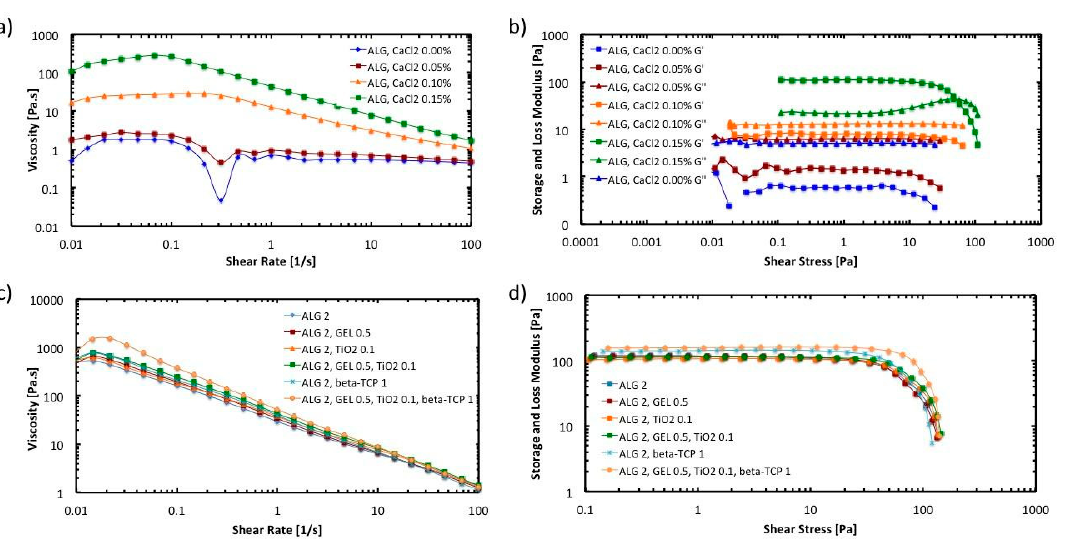
Figure 3. Rheology tests: ( a ) Flow curve for pre-crosslinked hydrogel inks; ( b ) Amplitude sweep for pre-crosslinked hydrogel inks; ( c ) Flow curve of hydrogels with different compositions with 0.20% of pre-crosslinker; ( d ) Amplitude sweep (Storage modulus) of hydrogels with different compositions with 0.20% of pre-crosslinker.